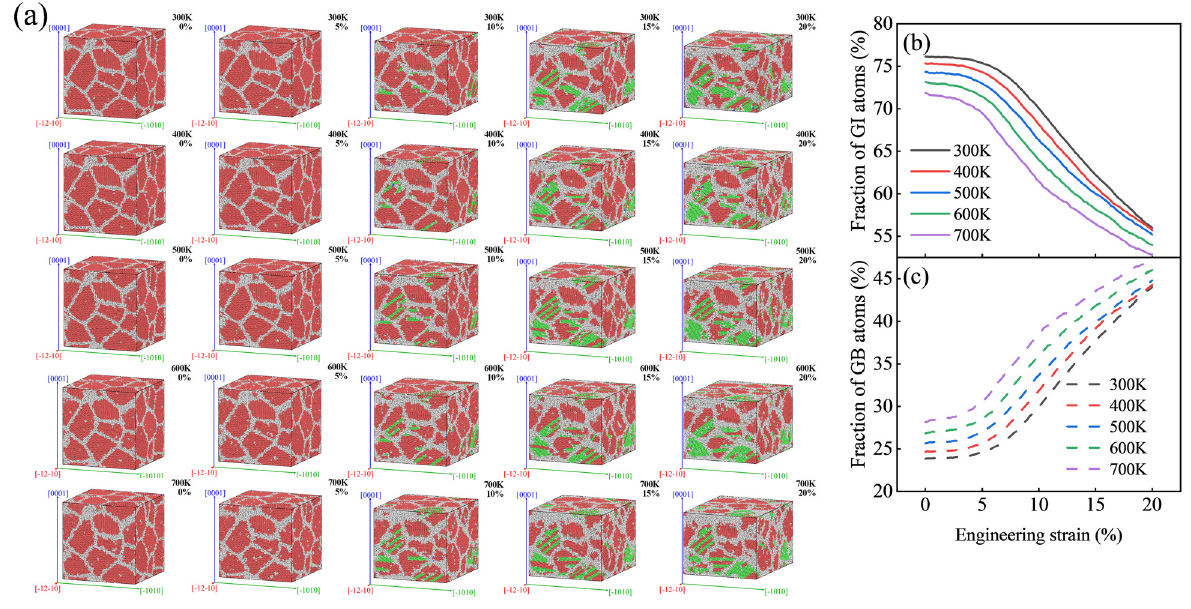
Figure 13: Grain boundary evolution under PSC: ( a ) CNA diagram, ( b ) GI atomic curve, and ( c ) GB atomic